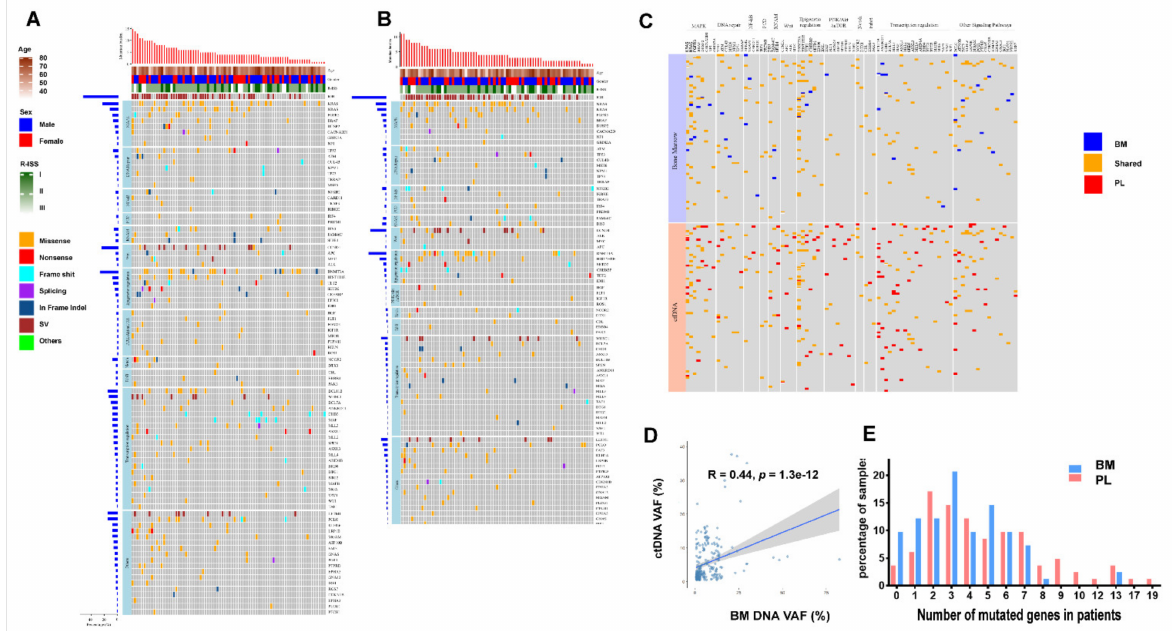
Figure 1. Comparison of the genomic landscape of ctDNA and Bone marrow (BM) DNA: ( A ) Somatic mutation profiles of newly diagnosed multiple myeloma (NDMM) patients from pre-treatment ctDNA sequencing of 413 cancer genes. Eighty-two patients were arranged along the x -axis. Age, sex, R-ISS stage, genes with somatic mutations were shown; ( B ) Somatic mutation profiles of NDMM patients from pre-treatment BM sequencing of 413 cancer genes; ( C ) Comparison of somatic mutation detected in ctDNA and paired BM DNA; ( D ) The relationship of variant allele frequencies (VAFs) between ctDNA and paired BM DNA; ( E ) Number of mutated genes in ctDNA and paired BM